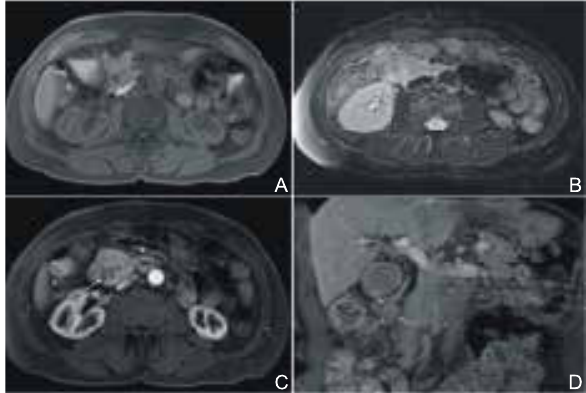
Figure 4 Gadopentetate dimeglumine (Magnevist®, Bayer Schering Pharma AG, Berlin, Germany) enhanced abdominal magnatic resonance image scan showed the lesion on T1- weighted image (A), T2- weighted image (B), arterial phase (C) and venous phase (D).